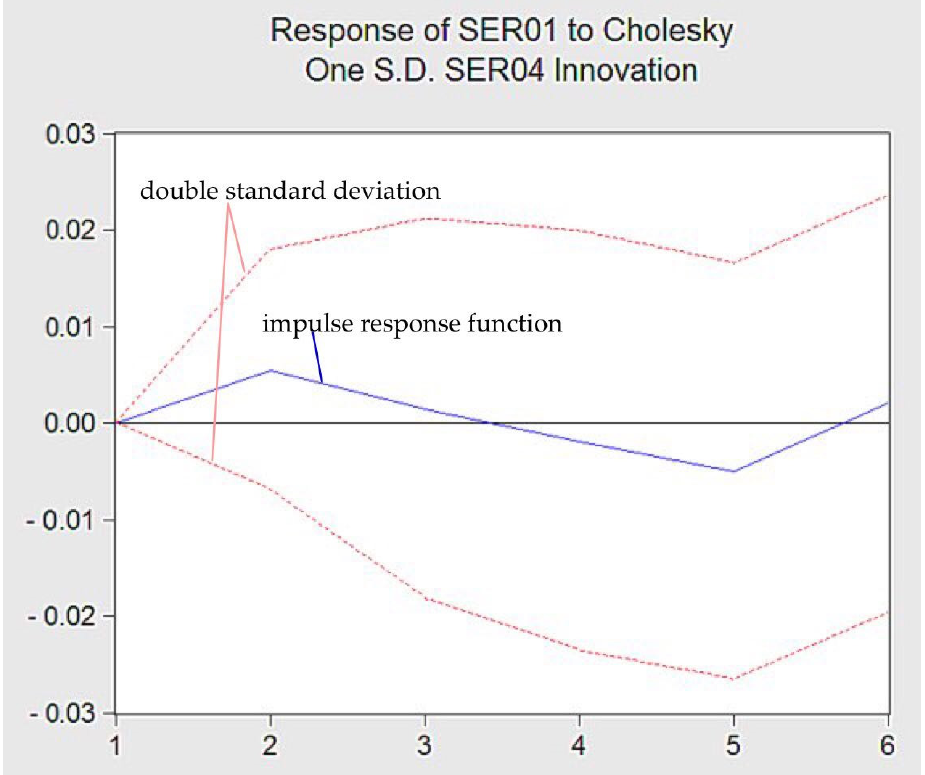
Figure 9. Impulse Response of carbon emissions to economy. Table 7. The variance decomposition of the changes of each endogenous variable in the VAR model. Variance Decomposition of